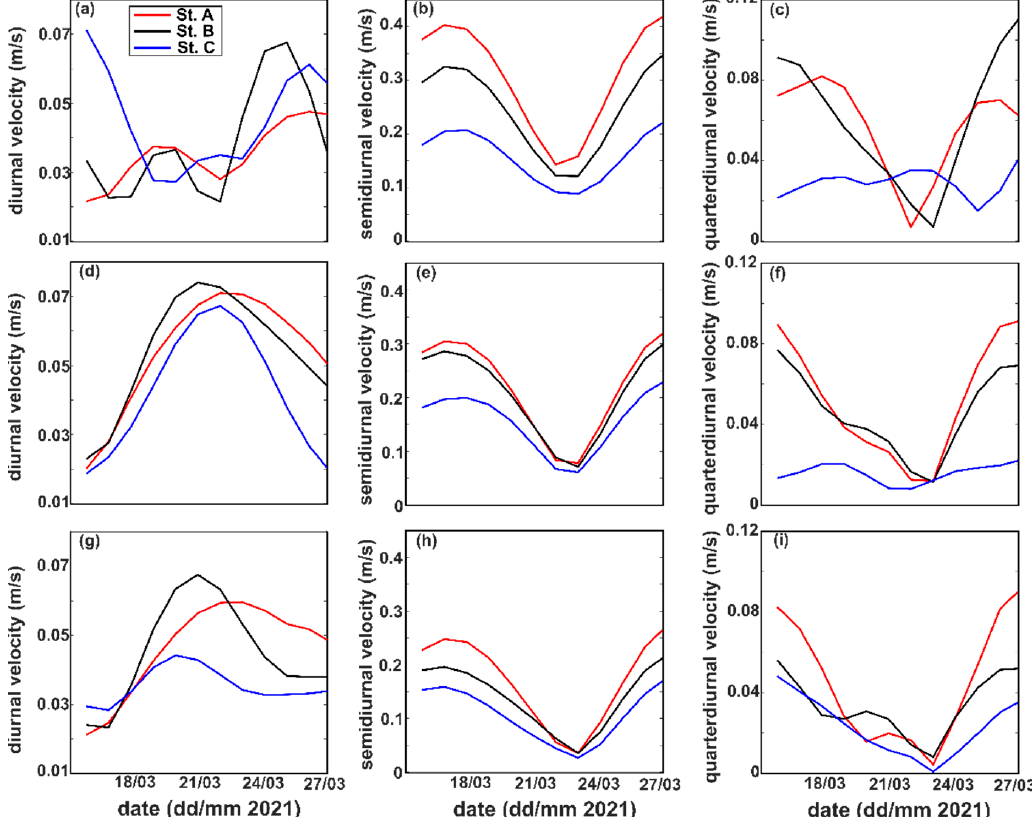
Figure 7. The diurnal velocity ( a , d , g ), semidiurnal velocity ( b , e , h ), and quarterdiurnal velocity ( c , f , i ) at upper (top row), mid- (middle row), and lower depth (bottom row) at Stations A, B, and C.